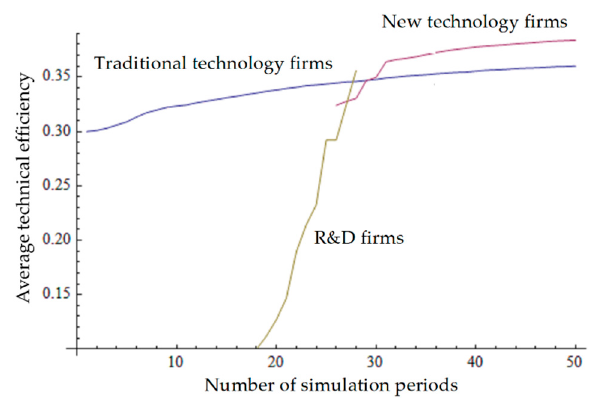
Figure 3. Change of a firm’s average technical efficiency.